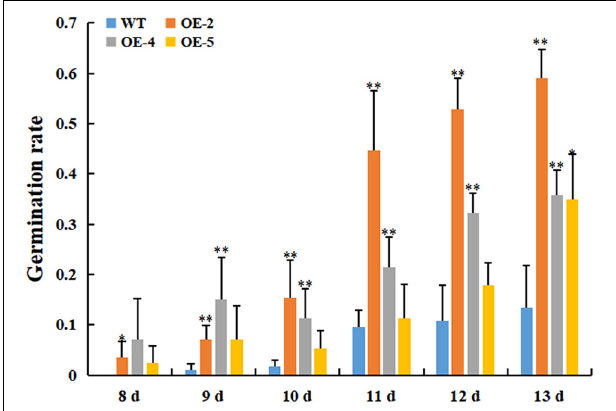
FIGURE 5 | Overexpression of RcGPX4 increased seed germination in transgenic plants under cold stress. The surface-sterilized seeds of wild type and transgenic plants were sown on 1/2 MS media and grown at 4 ◦ C for 13 consecutive days. Data represent the mean ± SD of three independent biological replicates ( n = 42 seeds for each replicate). Asterisks indicate a significant difference between wild type and overexpressed lines ( ∗ P < 0.05, ∗∗ P < 0.01, student’s t -test). WT: wild-type; OE-2, OE-4, and OE-5: three T homozygous transgenic